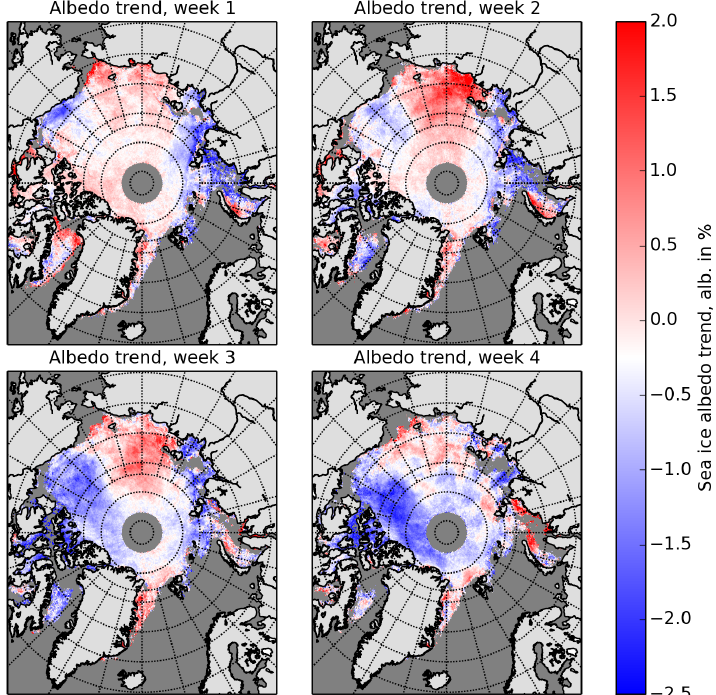
Figure 11. Broadband sea ice albedo trends (trend in albedo %) for the 4 weeks of June for the whole investigation period 2002–2011.